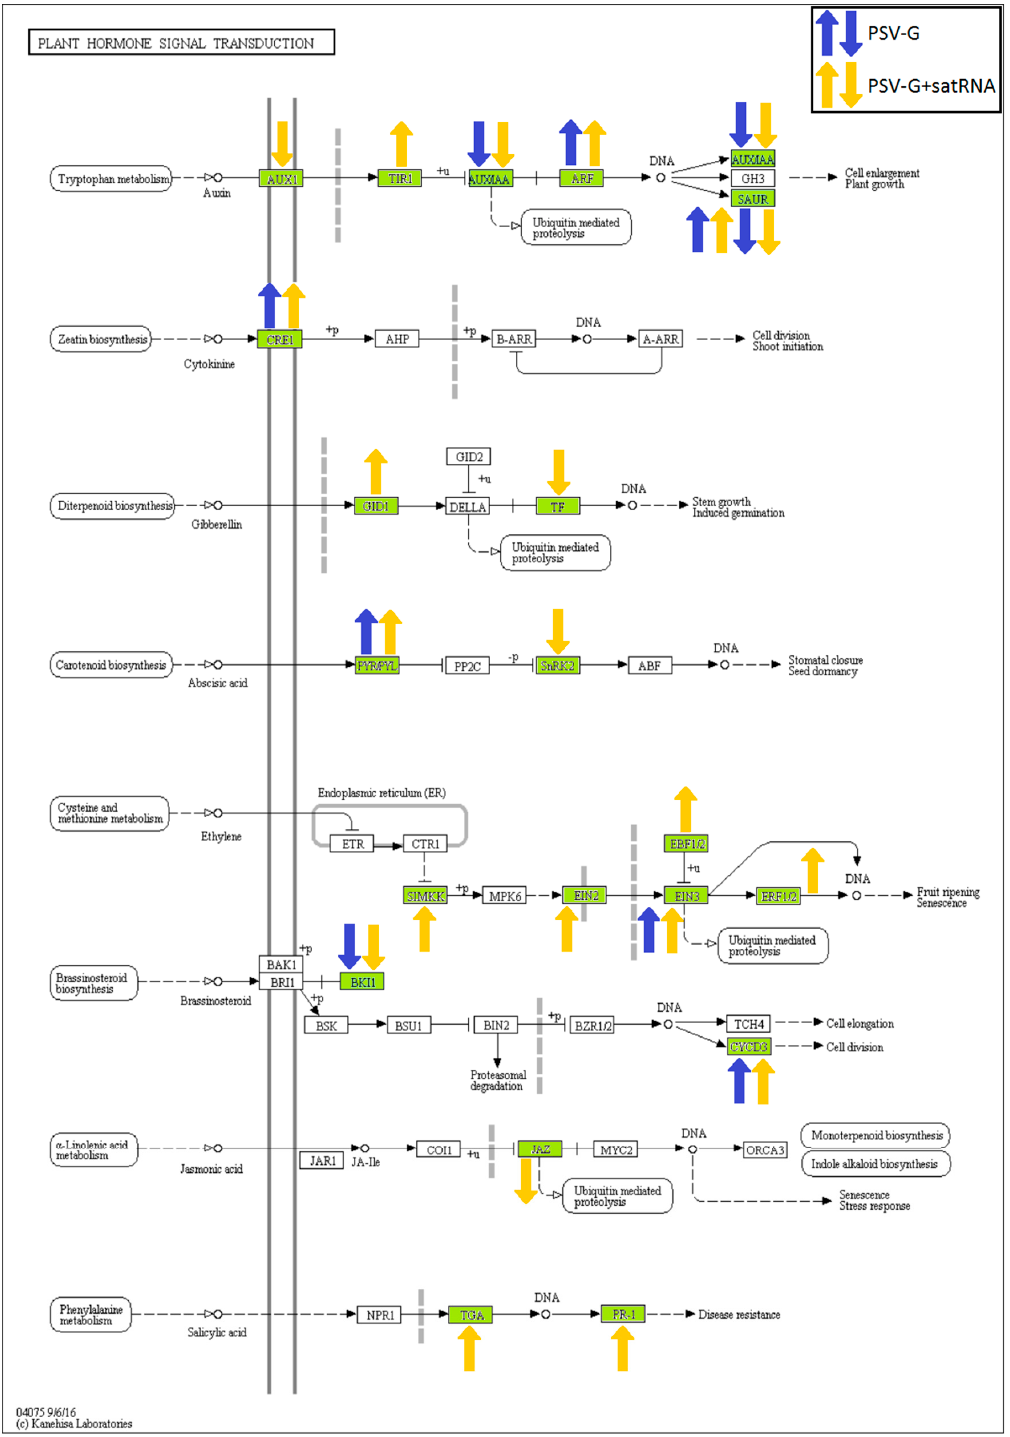
Figure 11. Differentially expressed genes (green boxes) associated with hormone signaling pathways in PSV and PSV + satRNA-infected plants. Up- and down-regulated DEGs are marked with arrows. The results are visualized in KAAS [35].